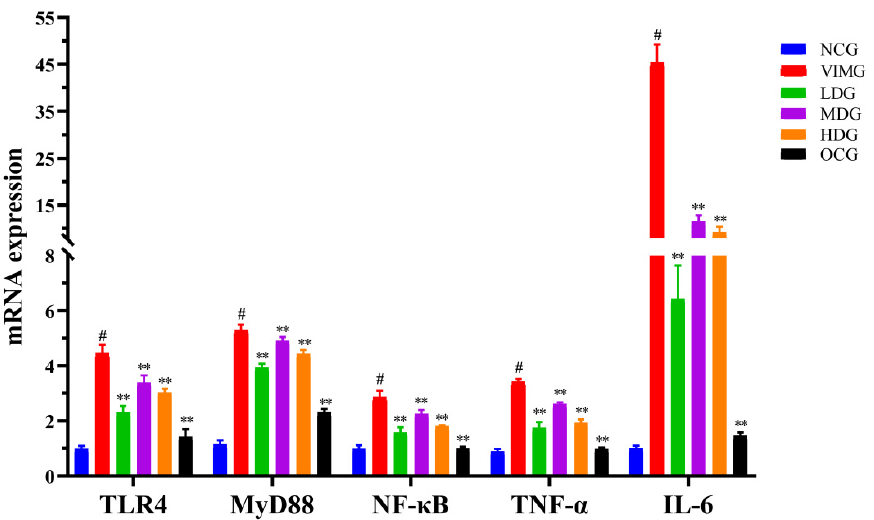
Figure 4. Comparison of relative expressions of TLR4, MyD88, NF- к B, TNF- α , and IL-6 mRNA in each group. Comparison with the virus infection model group (VIMG), ** p < 0.01. Comparison with the negative control group (NCG), # p < 0.01. Data were means ± SD of three independent experiments.